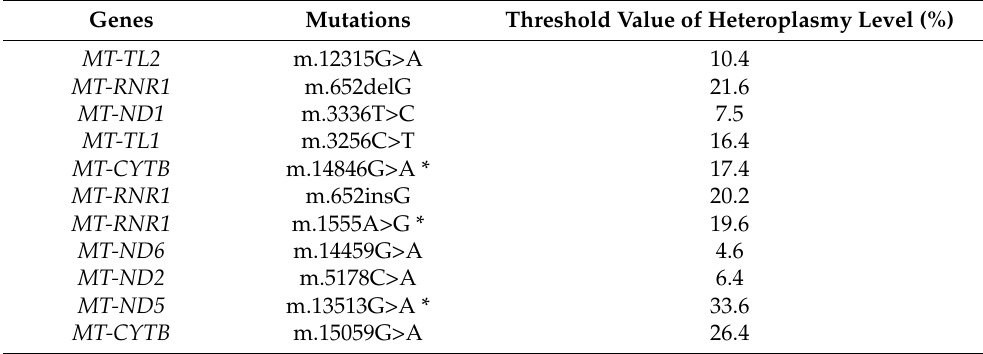
Table 3. The threshold value of heteroplasmy level of mtDNA mutations in thickened intima-medial layer of carotid arteries